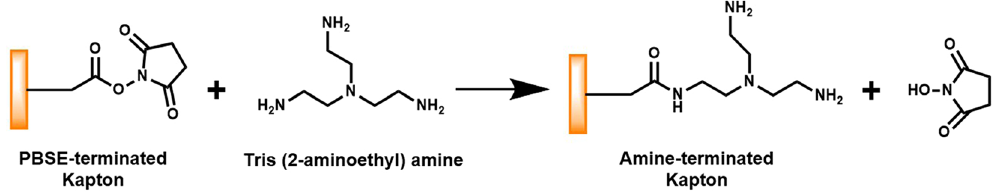
Figure 8. Reaction of the PBSE-terminated Kapton ® substrate with amine-containing tris (2-aminoethyl)